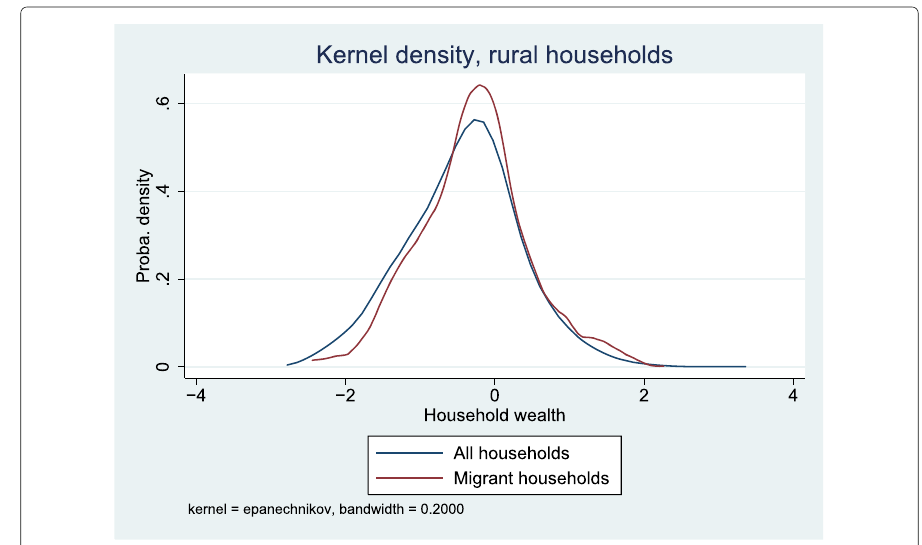
Fig. 5 Post-departure household wealth and migration: rural households